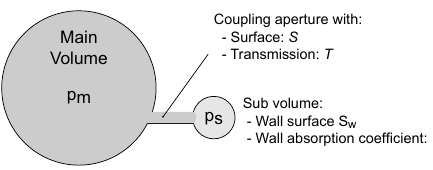
Figure 3. Cartoon of coupling between a main volume with surface power density p m and a small sub-volume with surface power density p s